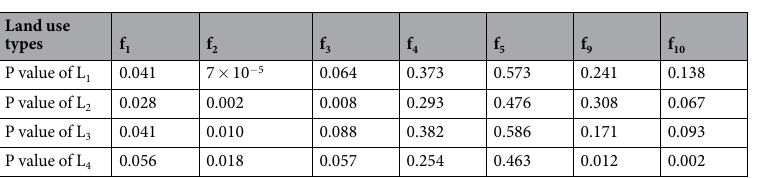
Table 3. Geographically determined weightings of factors influencing carbon sinks according to land use type